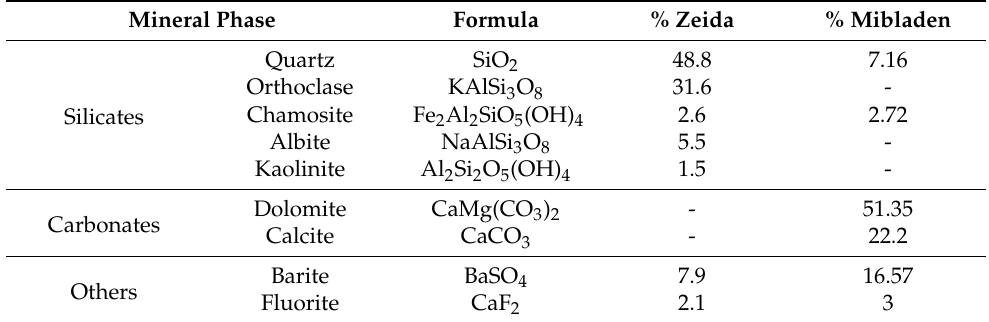
Table 1. Mineral characterization and mass percentage of the different crystallized phases as deter- mined by X-ray diffraction (in % of dry matter, w / w ) (adapted from [32], amorphous phases undetected). Mineral